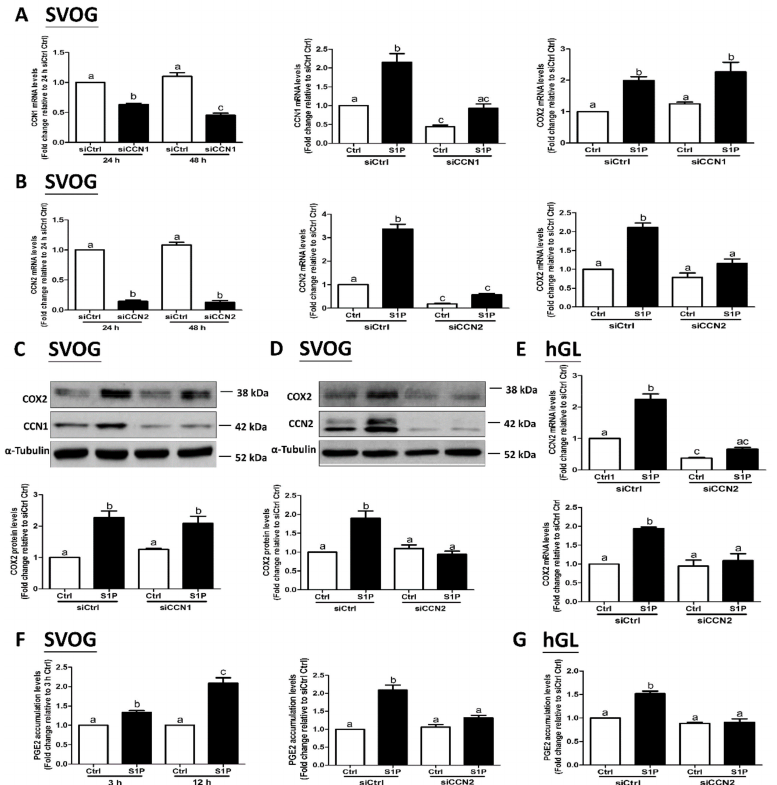
Figure 7. CCN2, but not CCN1, mediates the S1P-induced upregulation of COX2 and the increase in PGE2 production in human granulosa-lutein cells. ( A ) SVOG cells were transfected with 50 nM siCtrl or 50 nM CCN1 siRNA (siCCN1) for 48 h, followed by treatment with a vehicle control or 0.3 µ M S1P for 1 h. The mRNA levels of CCN1 and COX2 were examined using RT-qPCR. ( B ) SVOG cells